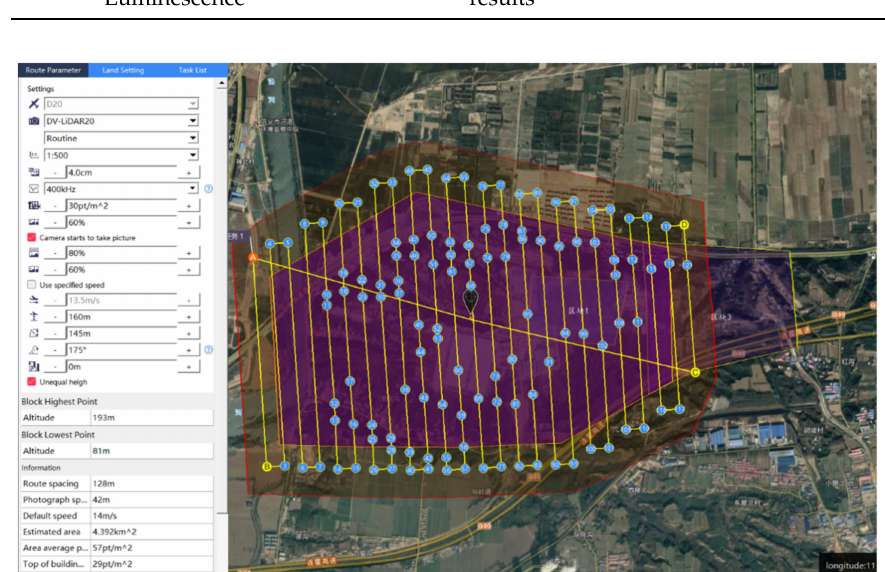
Figure 3. Flight route over the SHS